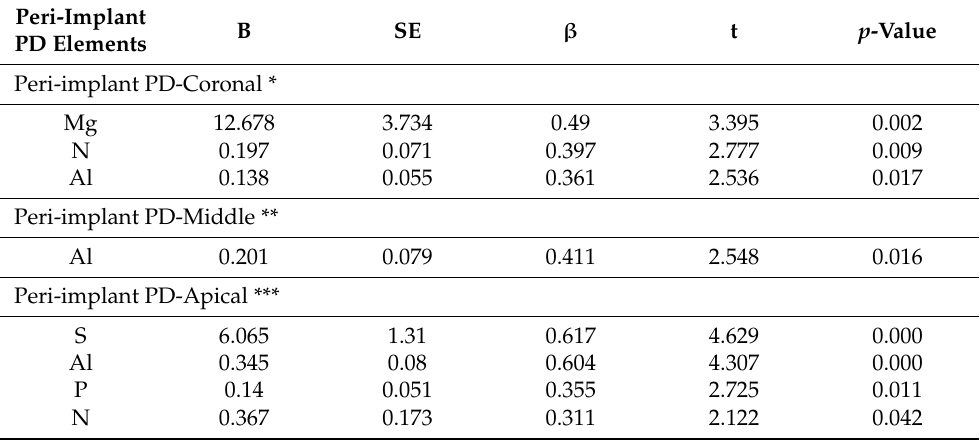
Table 4. Multiple step linear regression analysis of elements affecting the relationship between peri-implant pocket depth and implant surface chemical analysis in Group